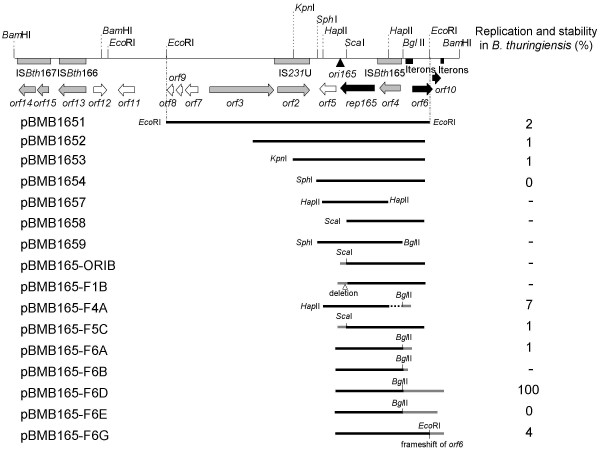
Physical map of the 20 kb fragment cloned from pBMB165 and determination of the minimal replicon. The predicted ORFs are shown by block arrows indicating the direction of transcription. The putative transposable elements are shown by hatched blocks. Replication-related ORFs, an origin of replication (ori165) and iterons region are in black. Other ORFs are shown by white block arrows. The stabilities of the different derivatives in B. thuringiensis are indicated. Inability of the constructs to replicate in B.thuringiensis is indicated by '-'. The fragments obtained by PCR amplification are indicated by the gray lines. The deletion in Rep165 is shown by the open triangle. The frame-shift introduced in orf6 is shown.